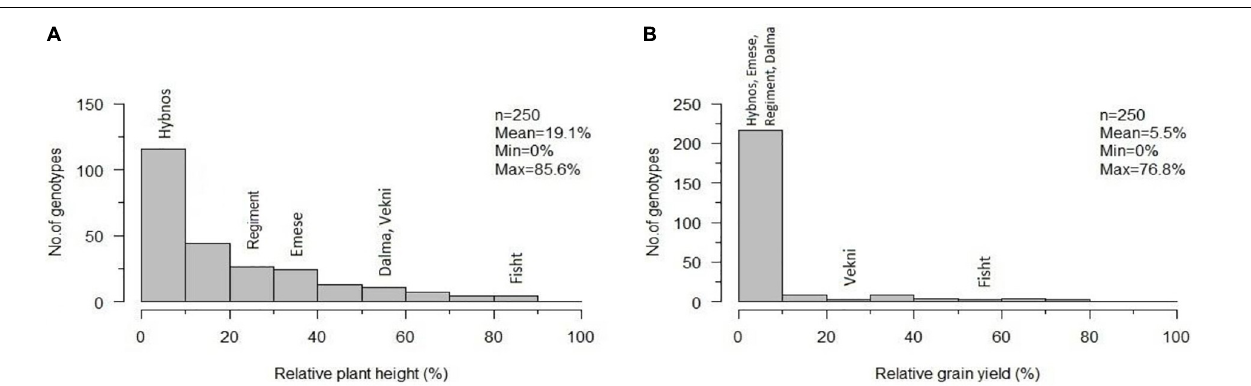
FIGURE 4 | Frequency distribution of accession means for relative plant height (A) and relative grain yield per plant (B) after artificial WDV infection of 250 hexaploid wheat accessions in comparison to the susceptible standard cultivars “Hybnos,” “Mv Regiment,” and “Mv Emese” and the partially resistant cultivars “Mv Dalma” and “Mv Vekni”. The variety “Fisht” is highlighted separately. n, number of tested accessions; Mean; Min; Max, overall mean, minimum, and maximum of the trait relative plant height (A) and relative grain yield (B) .